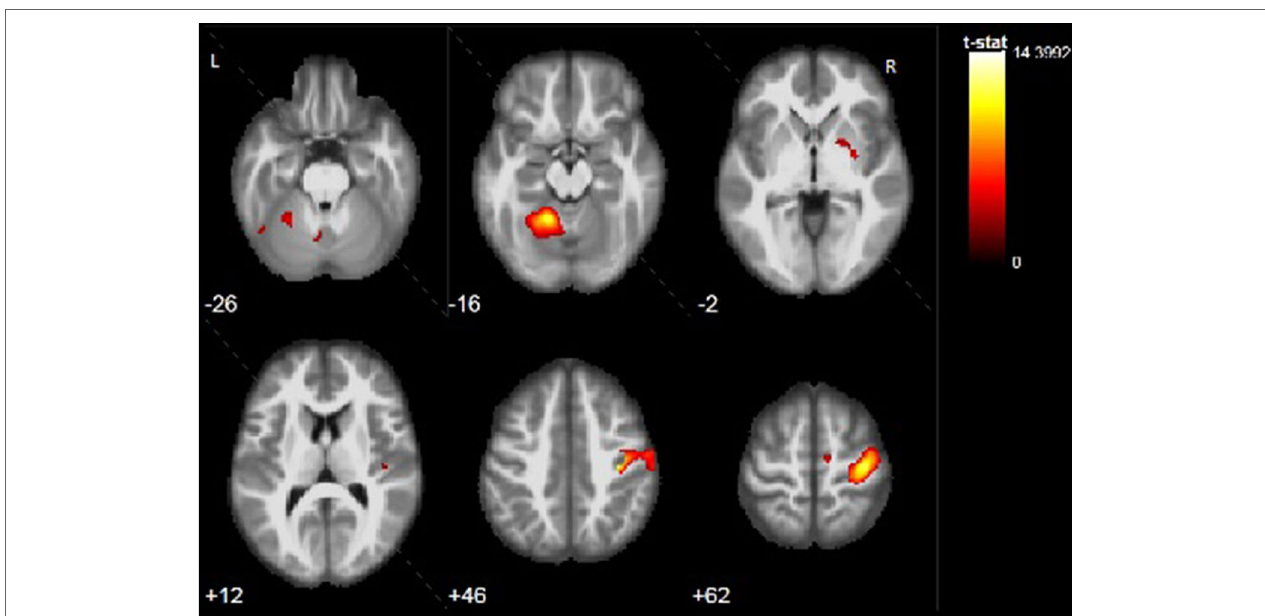
FIgURE 3 | Example of activation during motor task with the nonimpaired left hand (ML task) of P3. Activation is found in the right precentral gyrus, right putamen, and left cerebellar lobule IV, V, VIII, IX. Color bar represents t-value.